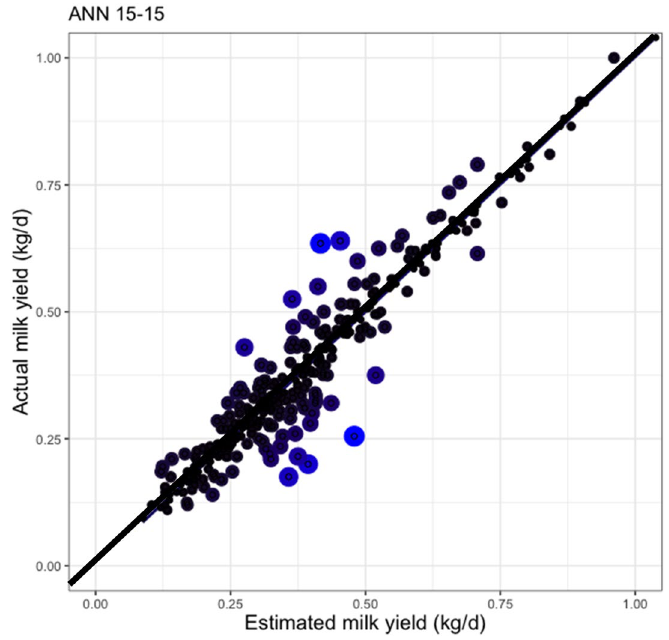
Figure 4. Residual analysis of ANN with two-layers (15–15 neurons) used to estimate milk yield using morphometrics measures of udder in Pelibuey sheep. The color and size of circles represents the magnitude of residuals. Black and blue color means a lower and higher residual values,